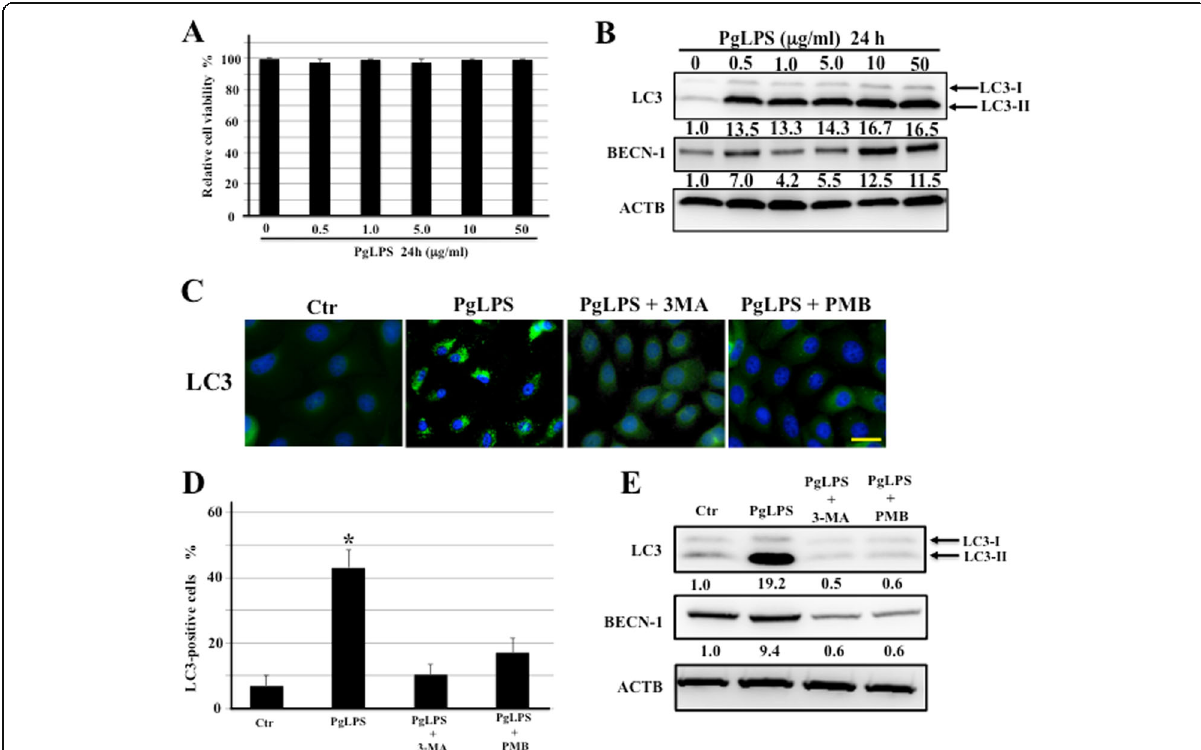
Fig. 5 Autophagy induction in cultured keratinocytes by PgLPS. a Cell viability was determined using trypan blue exclusion. The graph shows the viability of HaCaT cells exposed different concentrations (0, 0.5, 1.0, 5.0, 10, or 50 μ g/ml) of PgLPS for 24 h. Results are presented as a percentage of the trypan blue exclusion in untreated cells. Data represent mean values ± SD in quadruplicate. b Western blotting analysis of LC3 and beclin-1 (BECN1) expression in HaCaT cells treated with different concentration of PgLPS for 24 h. β -actin (ACTB) was used as a loading control. Qauntification values shown in part were the fold increases normalized to those of ACTB on day 0. Results are shown below the corresponding blots. All experiments were performed in quadruplicate. c - e Effect of 3-MA or PMB on induction of autophagy in PgLPS-stimulated HaCaT cells. HaCaT cells were treated with 10 μ g/ml PgLPS with or without 10 mM 3-MA or 100 μ g/ml PMB for24 h. c Immunocytochemical detection of LC3-positive autophagosomes (green) in keratinocytes. Bar=50 μ m. d Quantitative analysis of the percentage of LC3-positive cell ± SD from five independent studies. *Significantly different at P <0.05 compared with HaCaT cells treated without PgLPS and treated with 3-MA or PMB. e Western blotting analysis of LC3 and BECN-1 expression. β -actin (ACTB) was used as a loading control. Band densities were presened as LC3 or BECN-1 expression fold-increases (normalized to ACTB) and compared with the results for untreated HaCaT cells. Quantification results are shown below the corresponding blots. All experiments were performed in